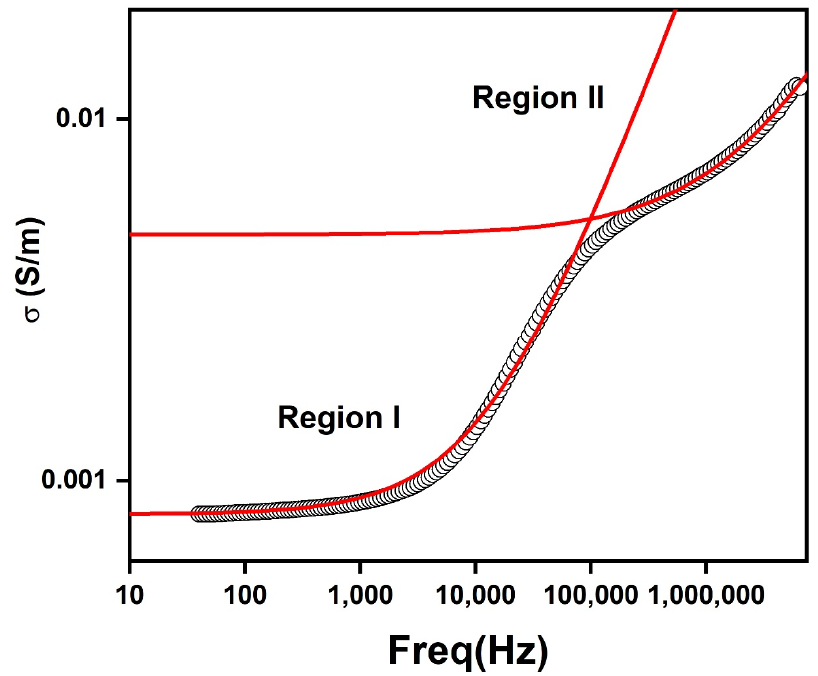
Figure 10. Power law fitting of frequency dependence of AC conductivity for PbS.